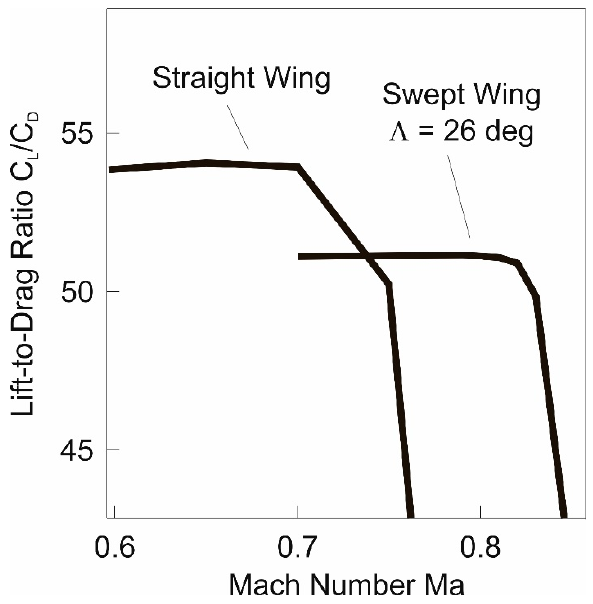
Figure 12. Effect of Mach number, 𝑀𝑎 , on lift-to-drag ratio of glider model wings (from [23]).